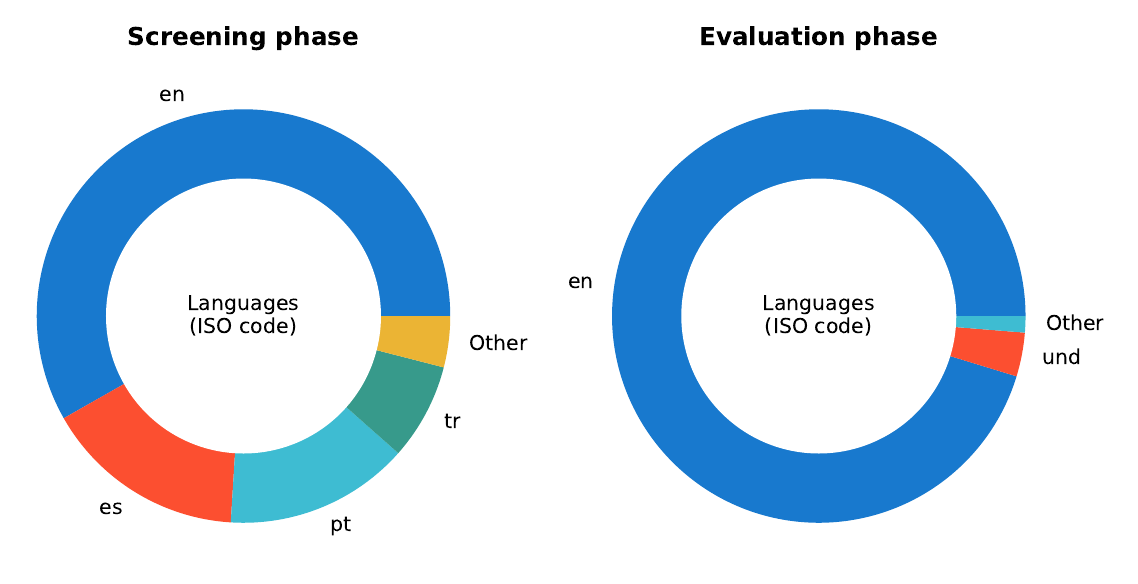
Figure 9. Observed languages (screening and evaluation phase of Use Case